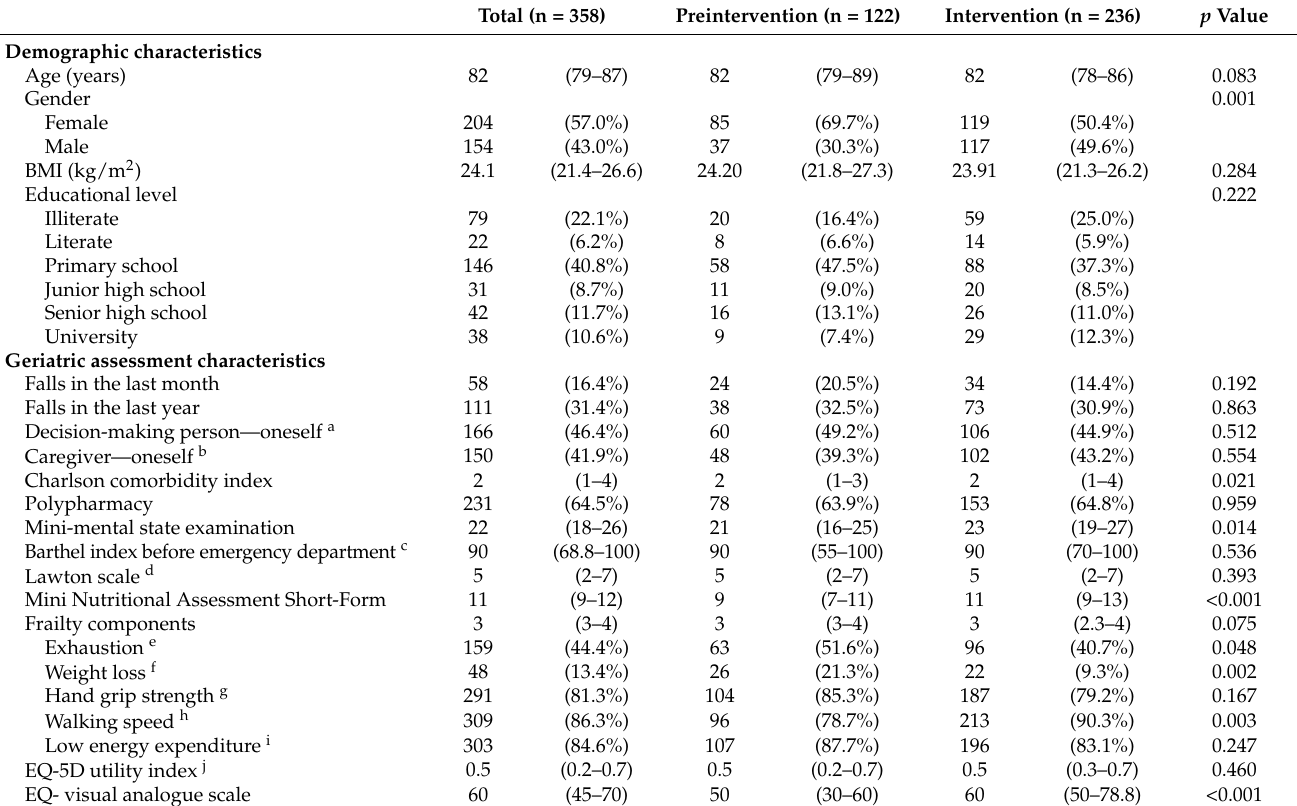
Table 1. Baseline characteristics of the participants.